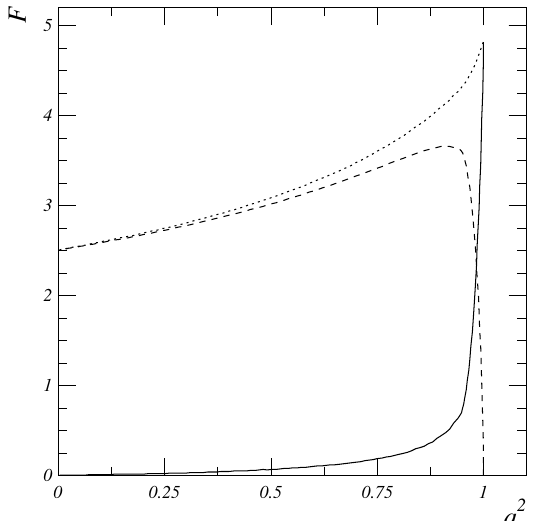
) vs. q 2 for 0 < q 2 < ( µ − m ) 2 at fixed p 2 , p 2 2 1